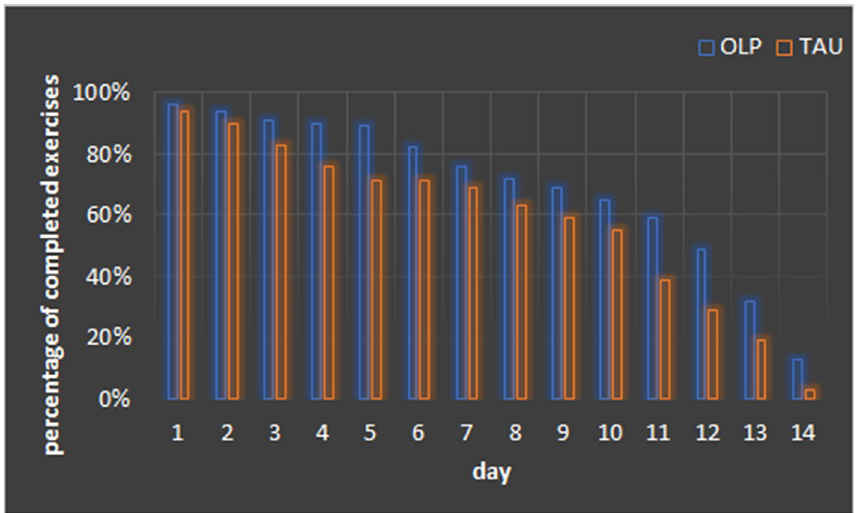
Figure 1. Percentage of completed Progressive Muscle Relaxation exercises per day and group. OLP open-label placebo, TAU treatment as usual without placebo.